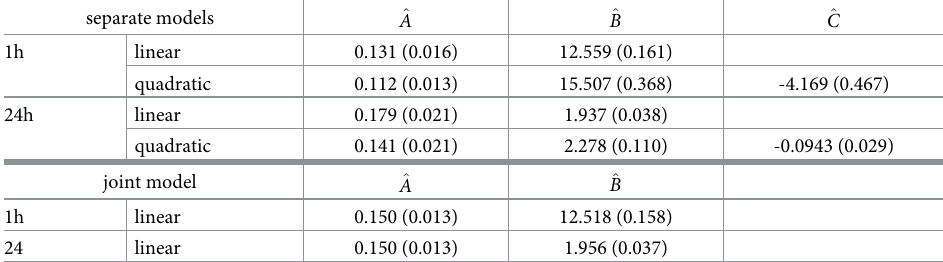
Table 2. Parameter estimates of linear model and quadratic model fitted to the yields (foci/cell). Standard errors are given in round